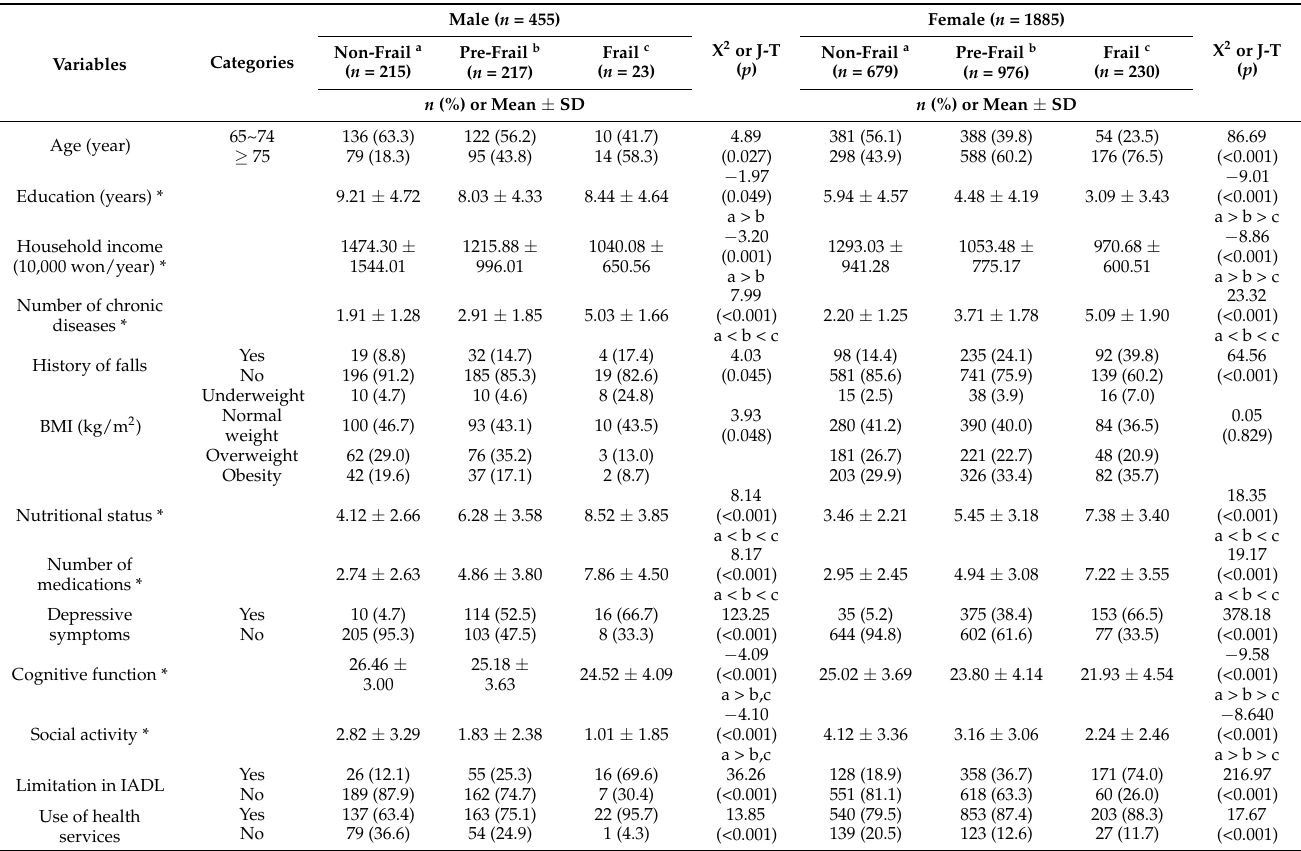
Table 2. The Differences in Frailty related Variables by Gender. n =